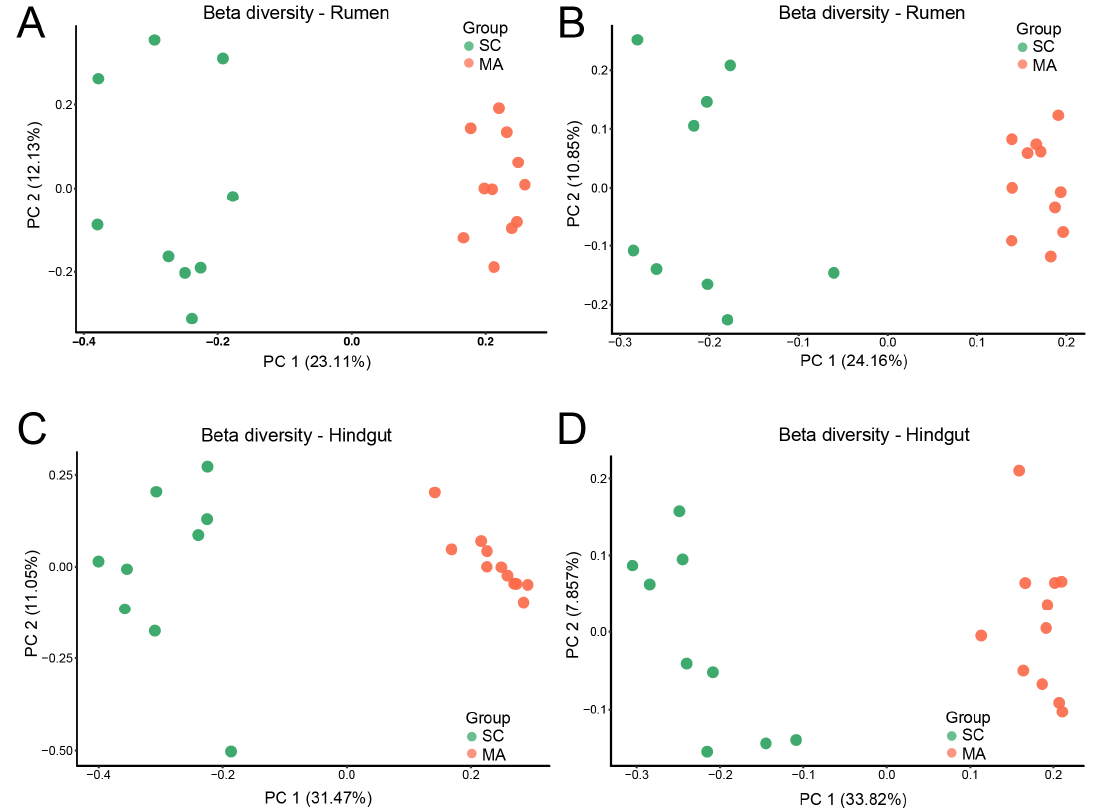
Figure 2. Beta diversity of rumen and hindgut bacteria between high-somatic-cell-counts cows with healthy patterns (SC) and mastitis patterns (MA). Principal variance components analysis (PCoA) with ( A ) Bray–Curtis and ( B ) weighted dissimilarity of rumen bacteria; PCoA with ( C ) Bray–Curtis and ( D ) weighted dissimilarity of hindgut bacteria.